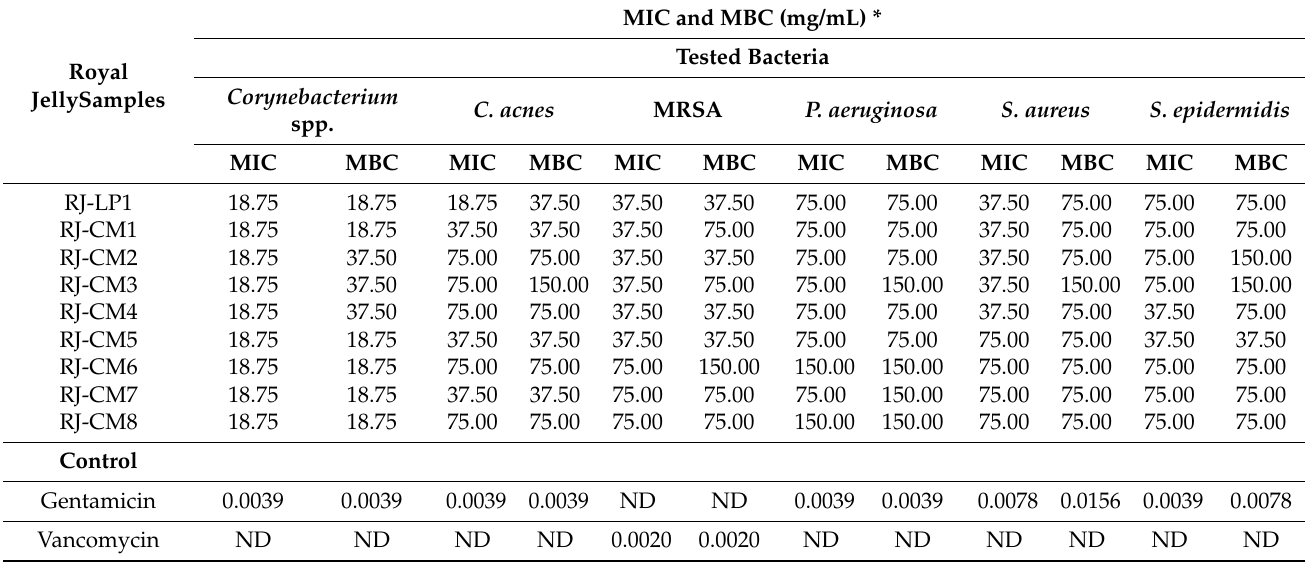
Table 2. Minimum inhibitory concentration (MIC) and minimum bactericidal concentration (MBC) of the royal jelly samples against skin pathogenic